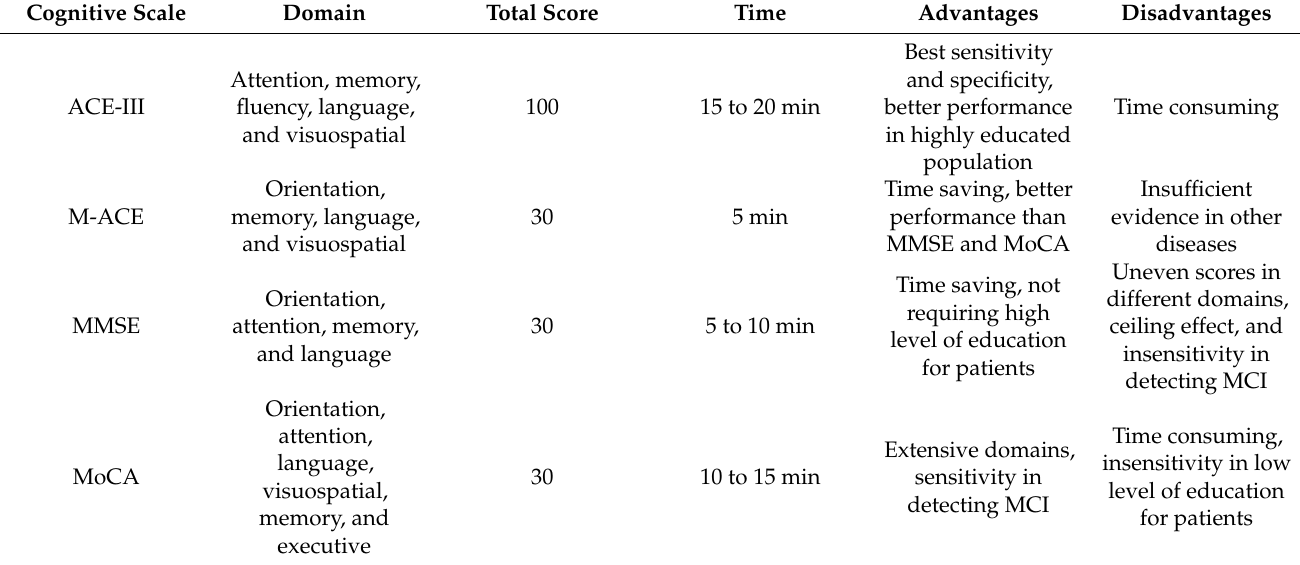
Table 3. Differences among ACE-III, M-ACE, MMSE, and